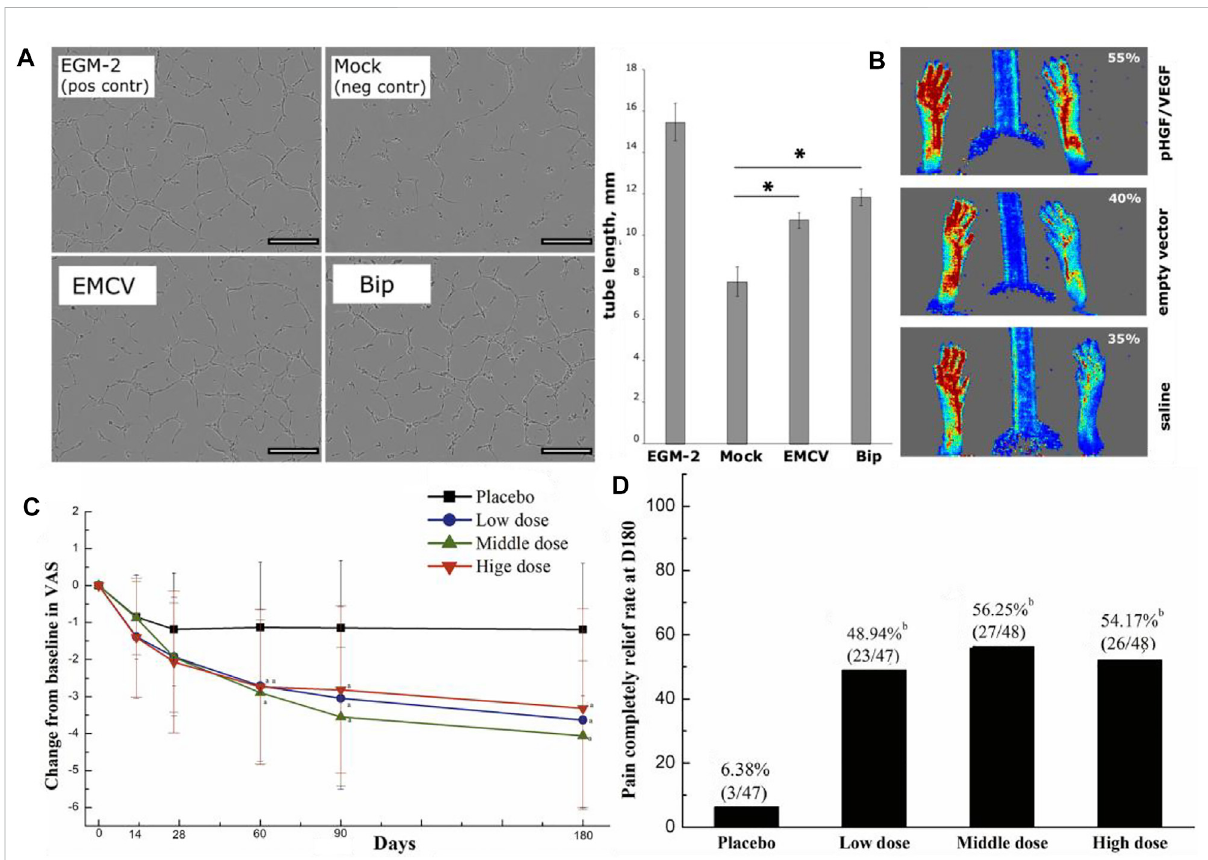
FIGURE 3 Schematic diagrams of growth factor therapy to improve angiogenesis. (A) Tube formation assay of HUVECs after HGF/VEGF165 plasmid treatment. Scale bar = 300 μ m. (B) Laser doppler perfusion imaging (LDPI) images of ischemic hind limbs and analytical diagrams of the perfusion rate. (C) ThereliefofrestpainafterHGFplasmidtreatment. (D) RateofcompletelypainreliefattheendofHGFplasmidtreatment. (A,B) arereprinted with permission from ref. (Slobodkina et al., 2020) and (C,D) are reprinted with permission from ref. (Gu et al.,